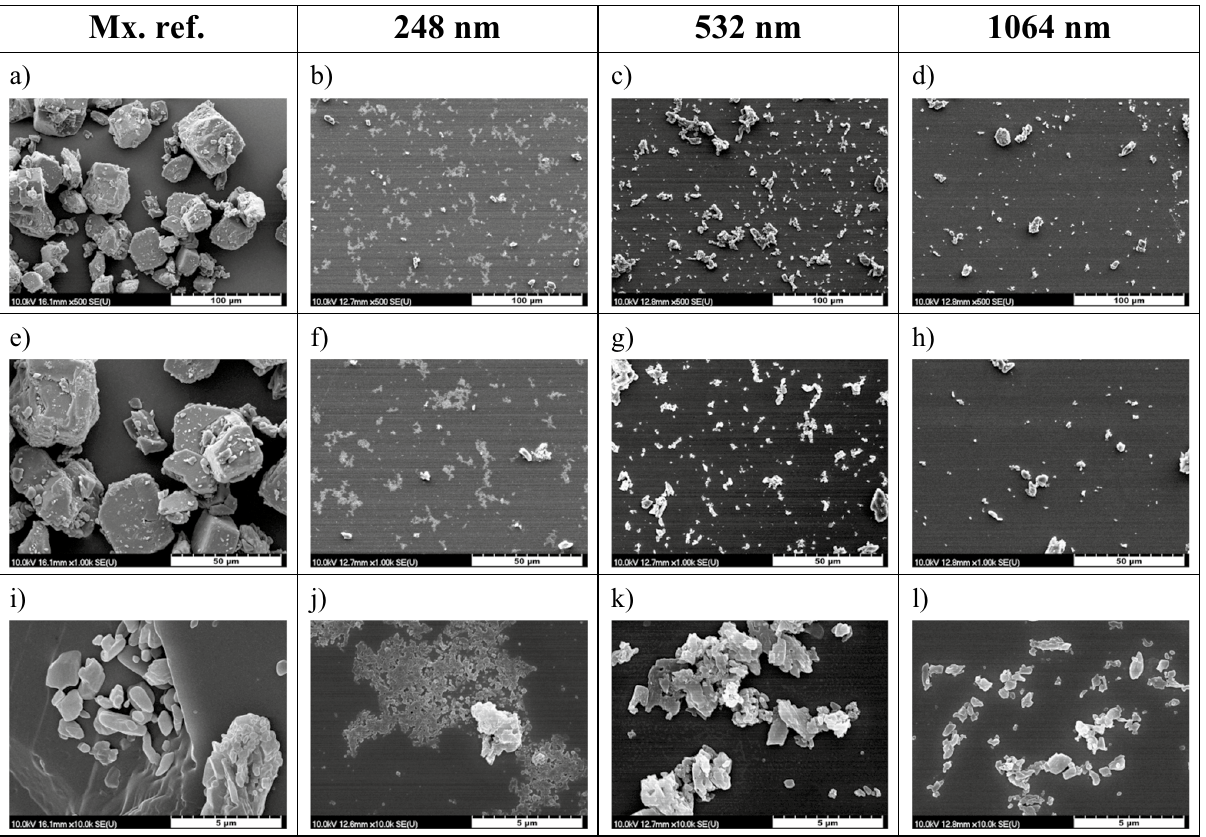
Figure 7. SEM images of the commercially available meloxicam powder (Mx. ref.) and the particles generated by PLAL at 248 nm, 532 nm and 1064 nm. Magnification: (a)–(d) : 500; (e)–(h) : 1 k; (i)–(l) : 10